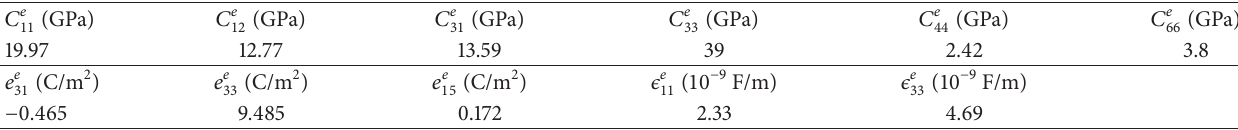
Table 2: Material properties of the homogenized material with 50% of